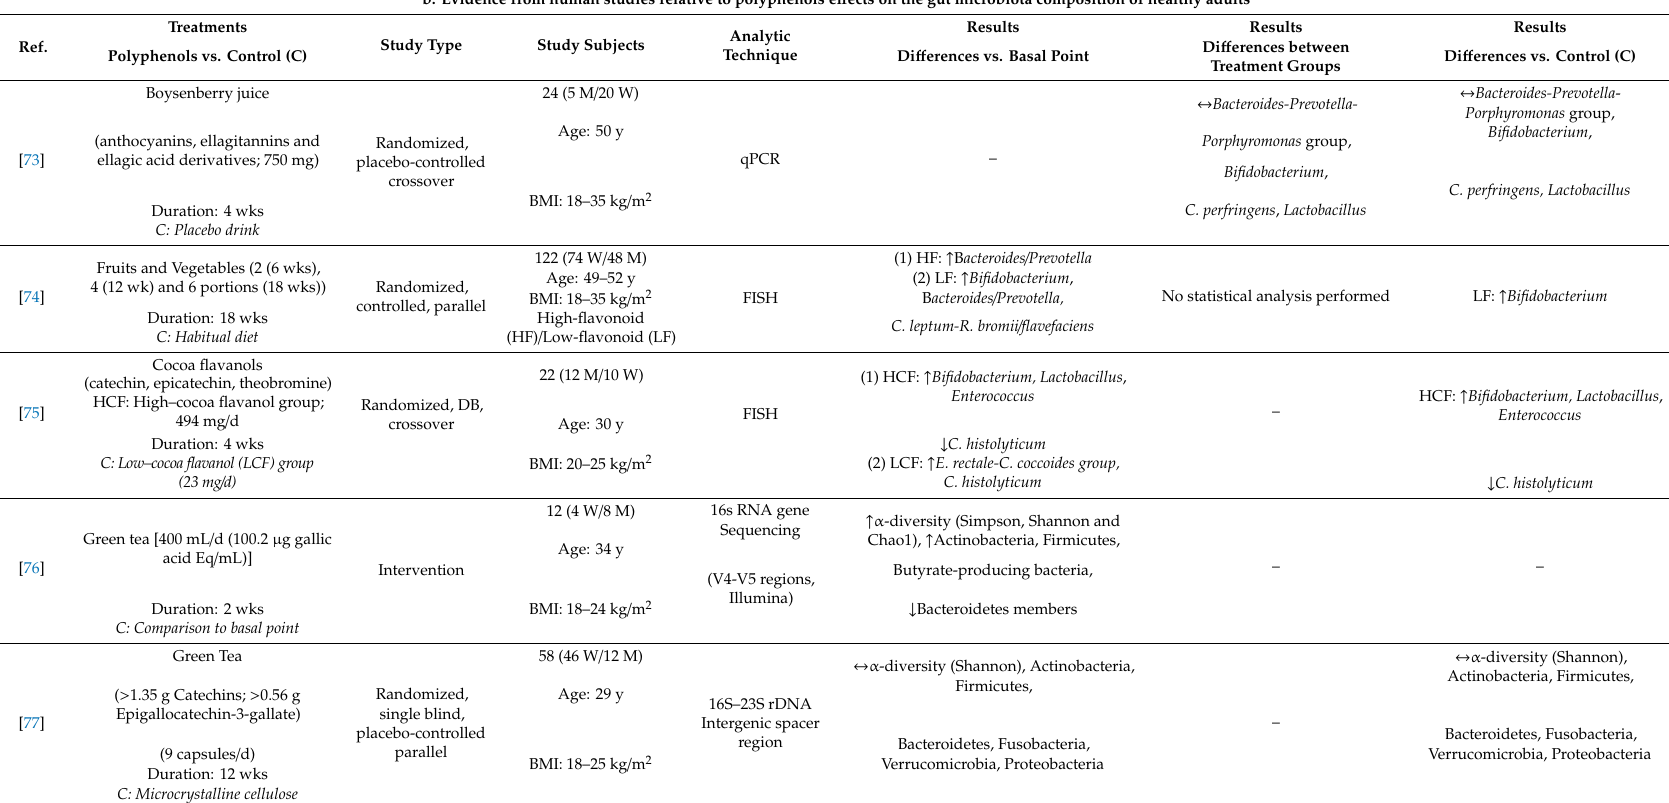
b. Evidence from human studies relative to polyphenols e ff ects on the gut microbiota composition of healthy adults